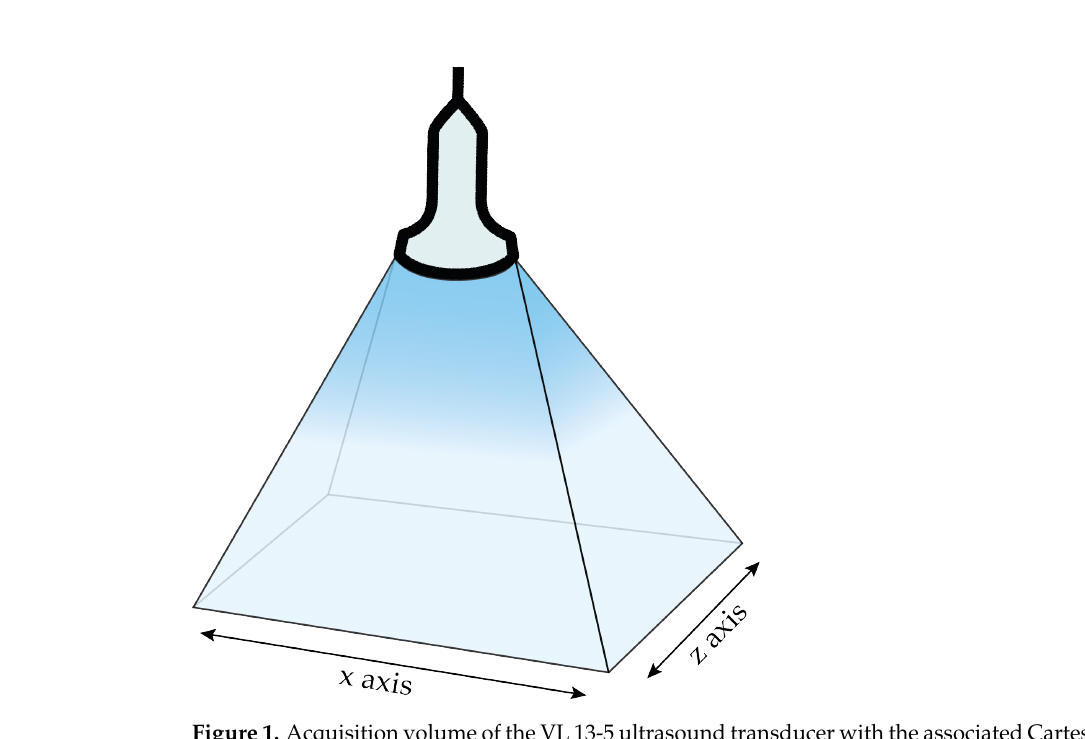
Figure 1. Acquisition volume of the VL 13-5 ultrasound transducer with the associated Cartesian